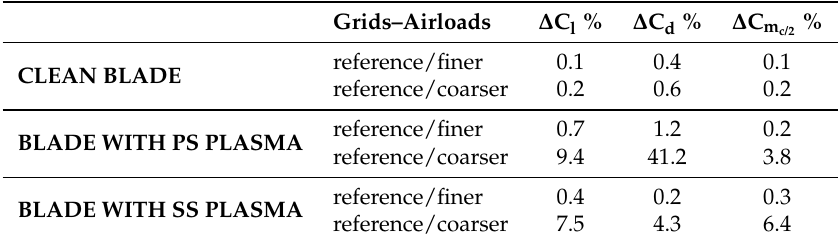
Table 1. Percent difference between the aerodynamic loads computed on the reference grid and the counterparts achieved on the finer and on the coarser mesh; clean cascade, with PS the actuated cascade and SS the actuated cascade; Re ∼ 350,000; α = 2 degrees.